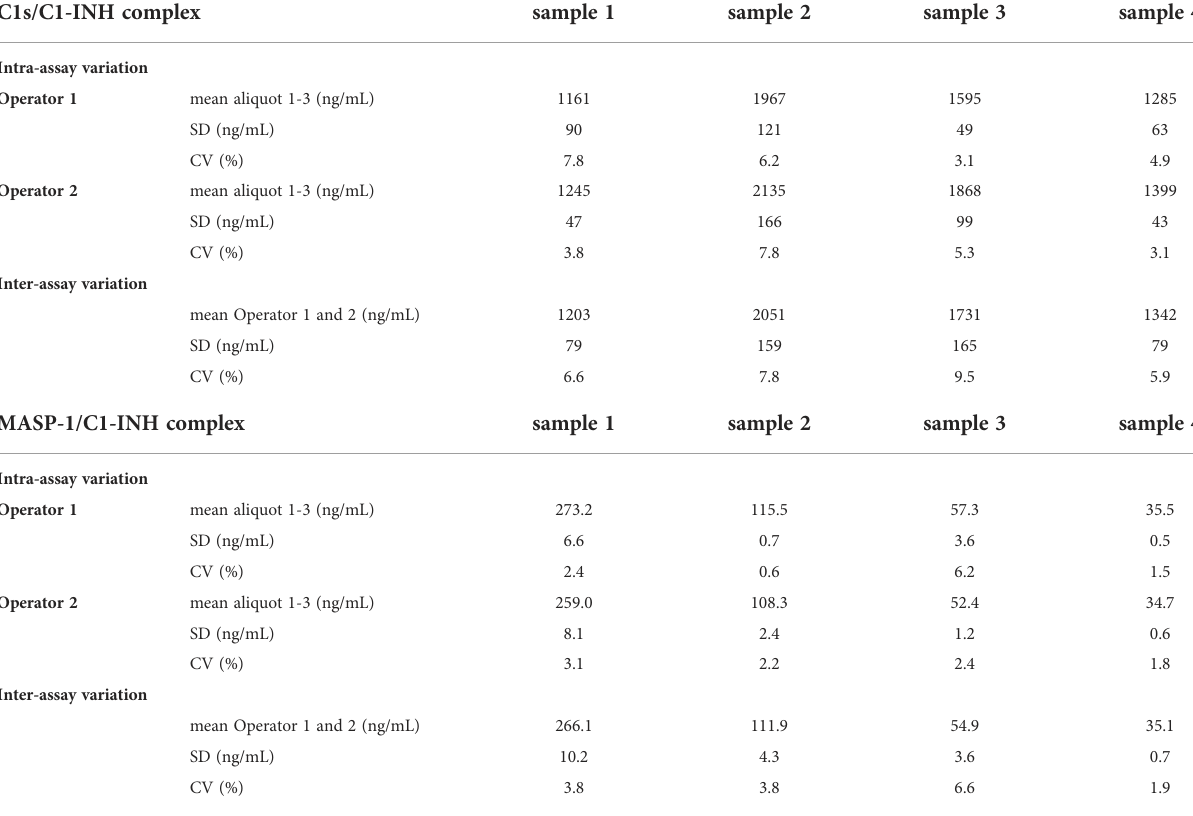
TABLE 2 Inter- and Intra-assay variation of C1-INH complex assays. C1s/C1-INH